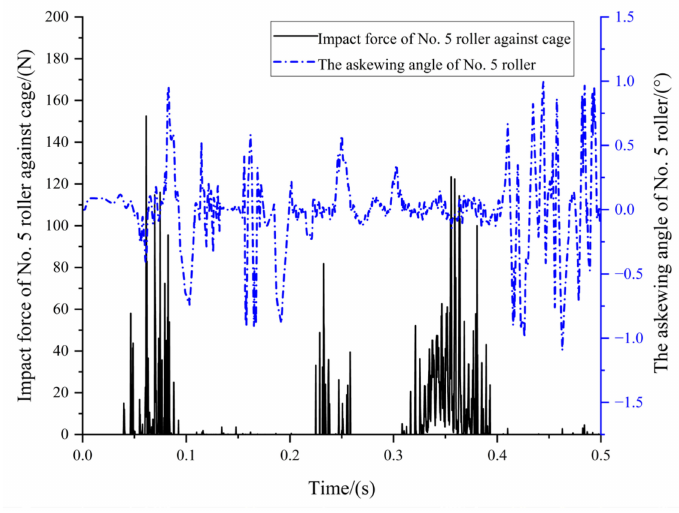
Figure 18. Collision force and the askewing angle change of No. 5